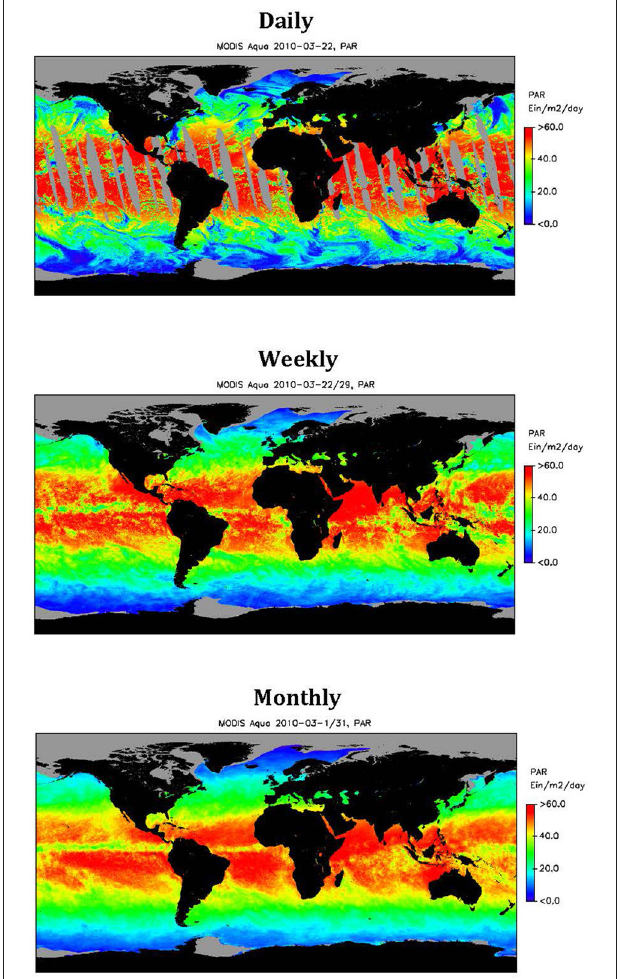
FIGURE 1 | Daily, weekly, and monthly above-surface PAR at 9km resolution, derived from MODIS-Aqua. Top : March 22, 2010; Middle : March 22-29, 2010; Bottom : March 1–31, 2010 (From NASA OBPG).